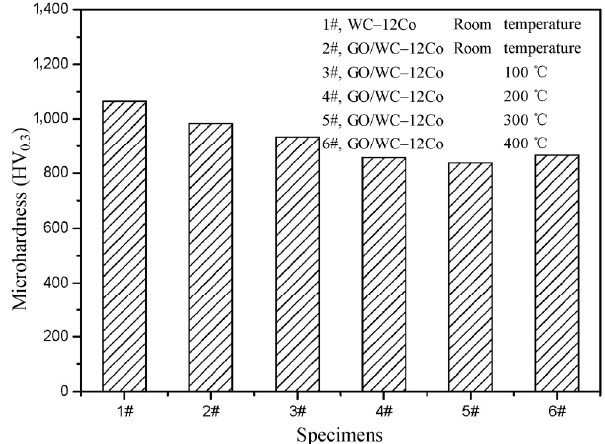
Fig. 7 Porosities of the coatings prepared via different heat treatment processes.